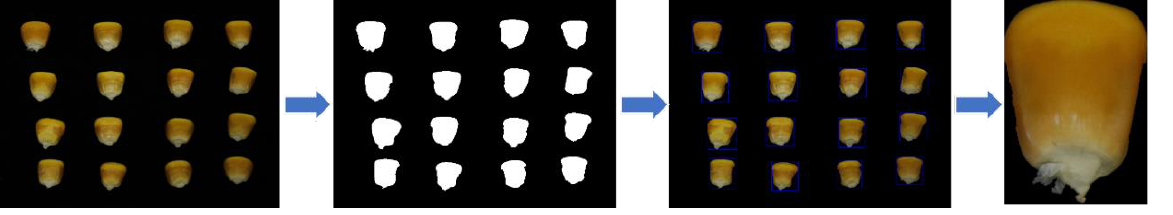
Figure 2. Maize seed image segmentation.